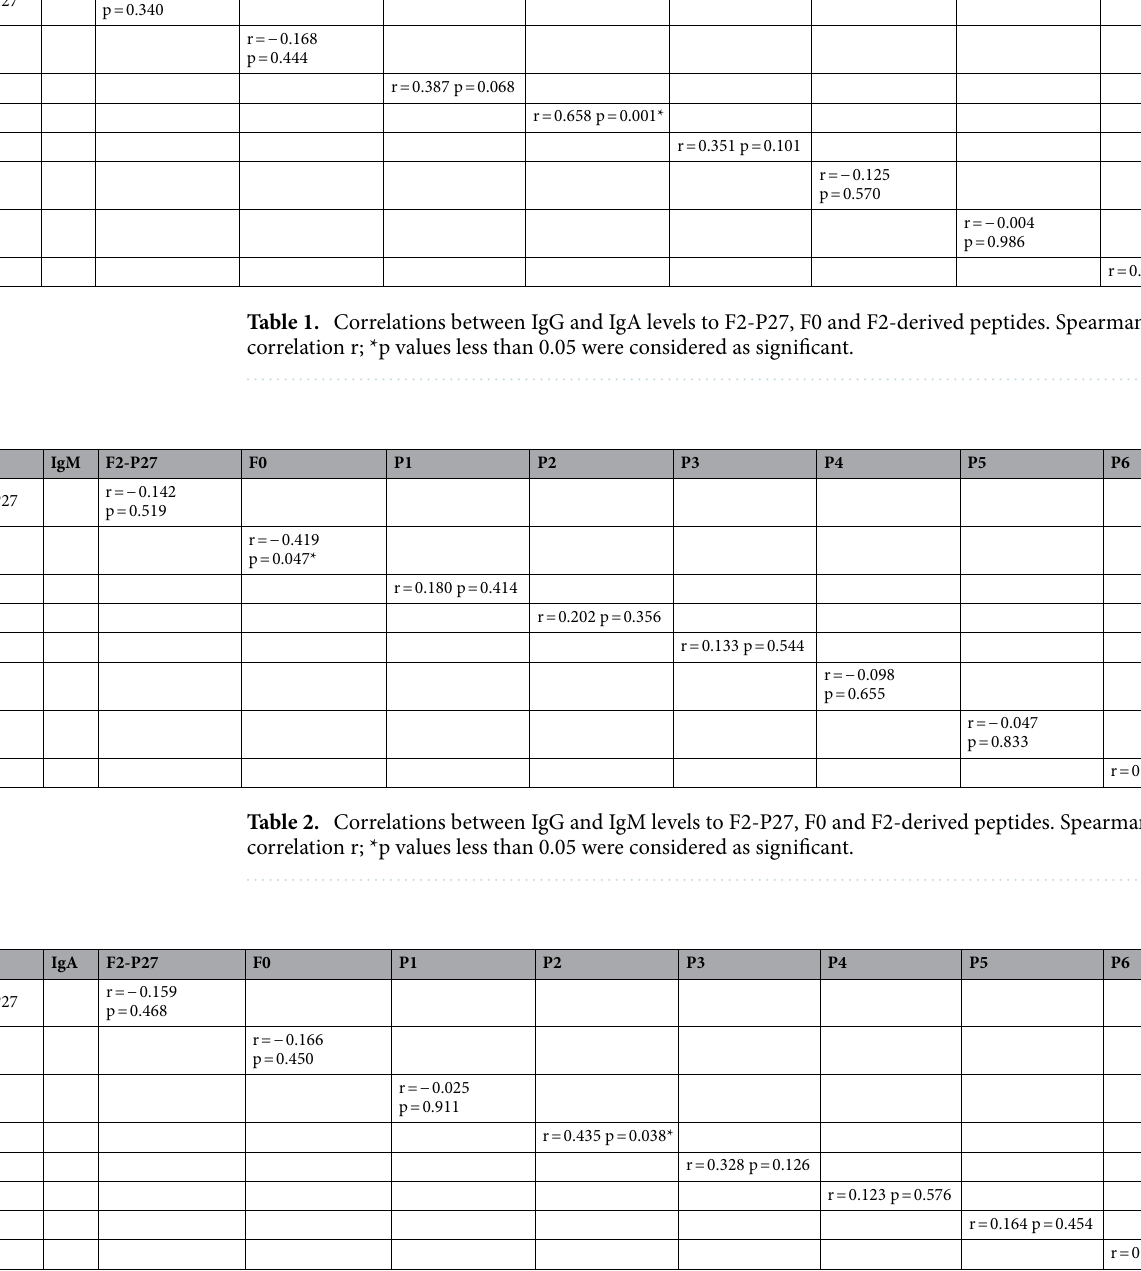
Table 3. Correlations between IgM and IgA levels to F2-P27, F0 and F2-derived peptides. Spearman correlation r; *p values less than 0.05 were considered as